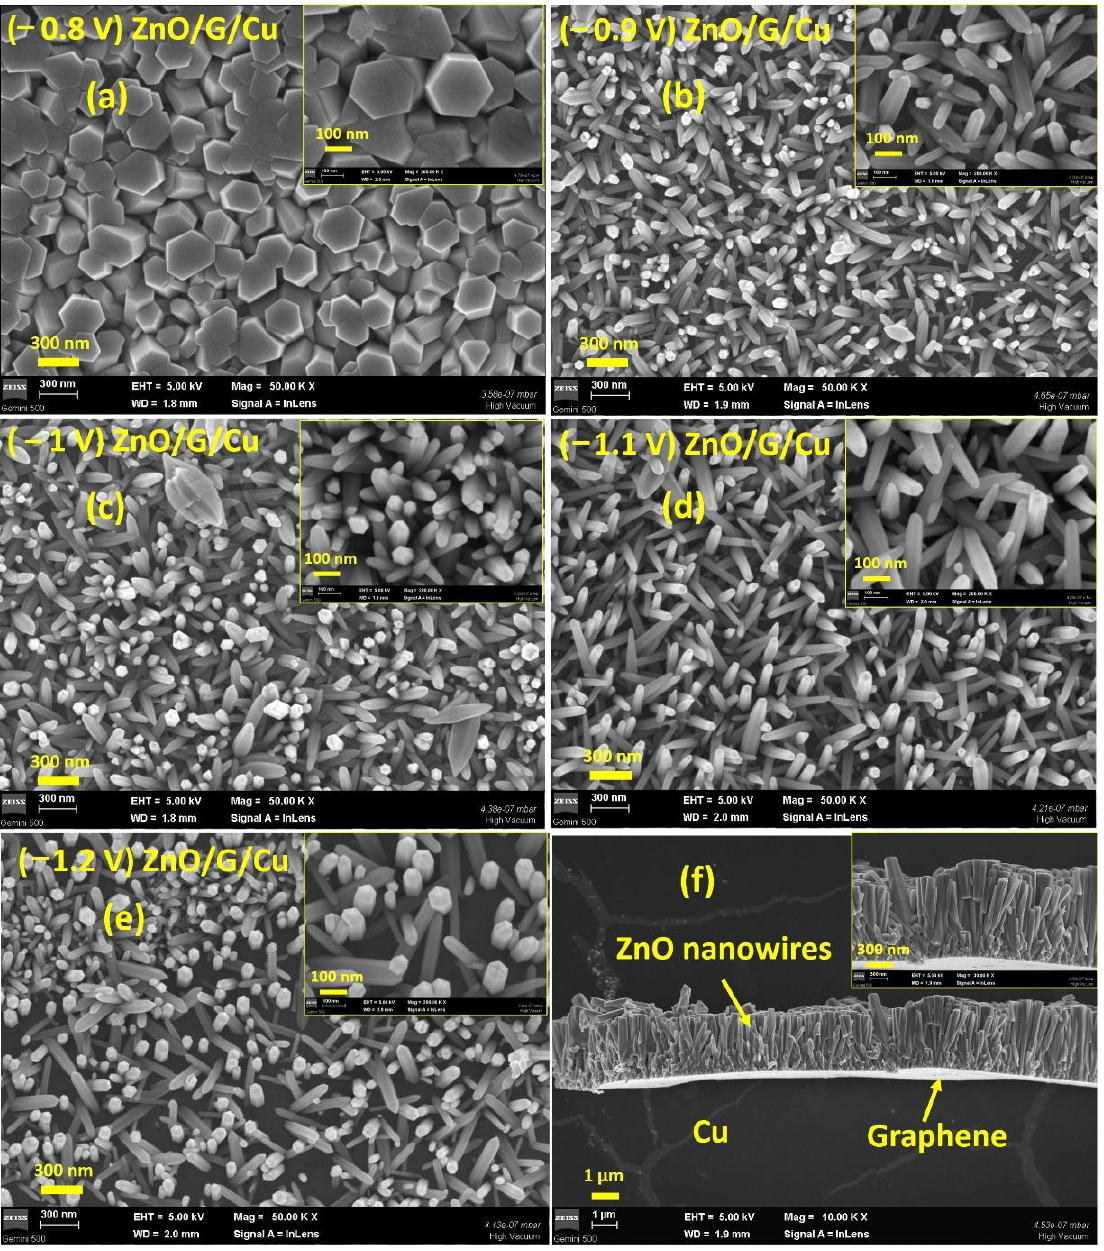
Figure 7. SEM images of ZnO nanowires grown on graphene/Cu at different potentials ( a ) −0.8 V, ( b ) −0.9 V, ( c ) −1 V, ( d ) −1 .1 V, ( e ) −1 .2 V vs. RE. ( f ) Cross-section of ZnO/G/Cu obtained at −0 .9 V vs. RE. The insets show the SEM images at higher magnification.